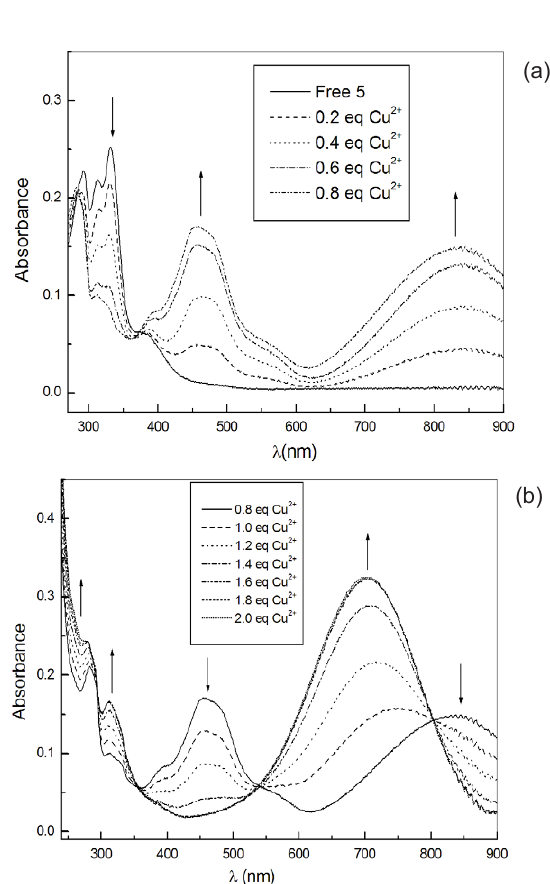
Figure 4. Absorption spectra of 5 (1.0×10 -5 M in CH upon addition of different equiv. Cu 2+ ions: 0.0~0.8 equiv. (a); 0.8~2.0 equiv.